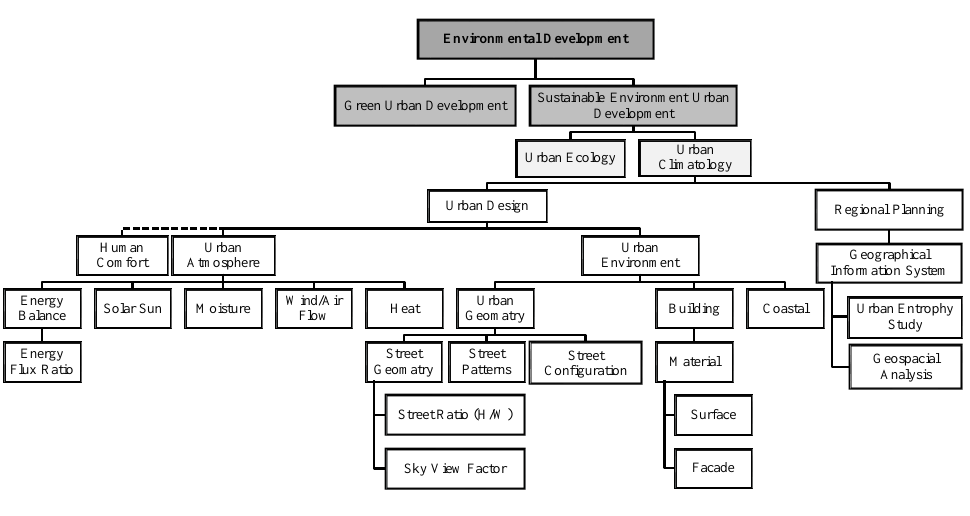
Fig. 2. Urban design and regional planning branches in taxonomy of urban climatology